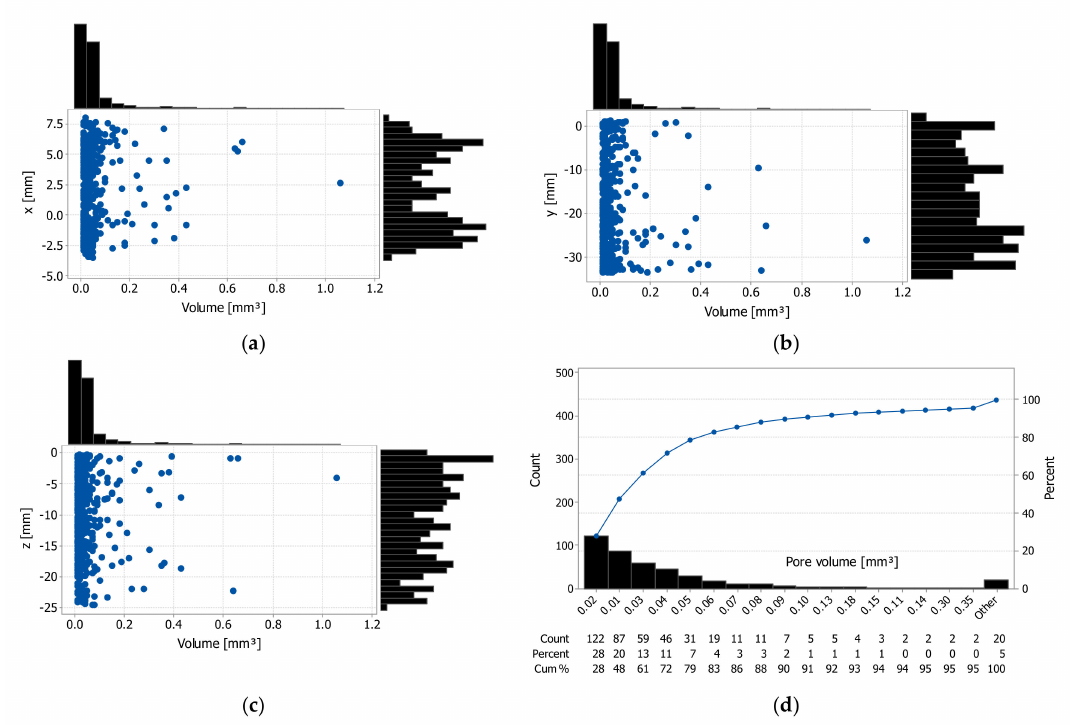
Figure 14. Closed pore volume distribution of sample S1: ( a ) versus X; ( b ) versus Y; ( c ) versus Z; ( d ) the number of pores versus pore